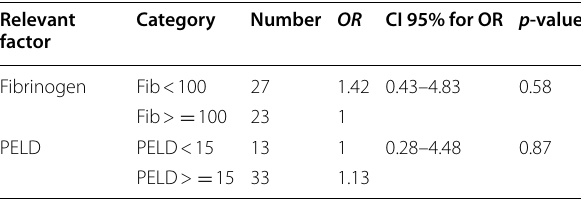
Table 7 Binary logistic regression to investigate the influence